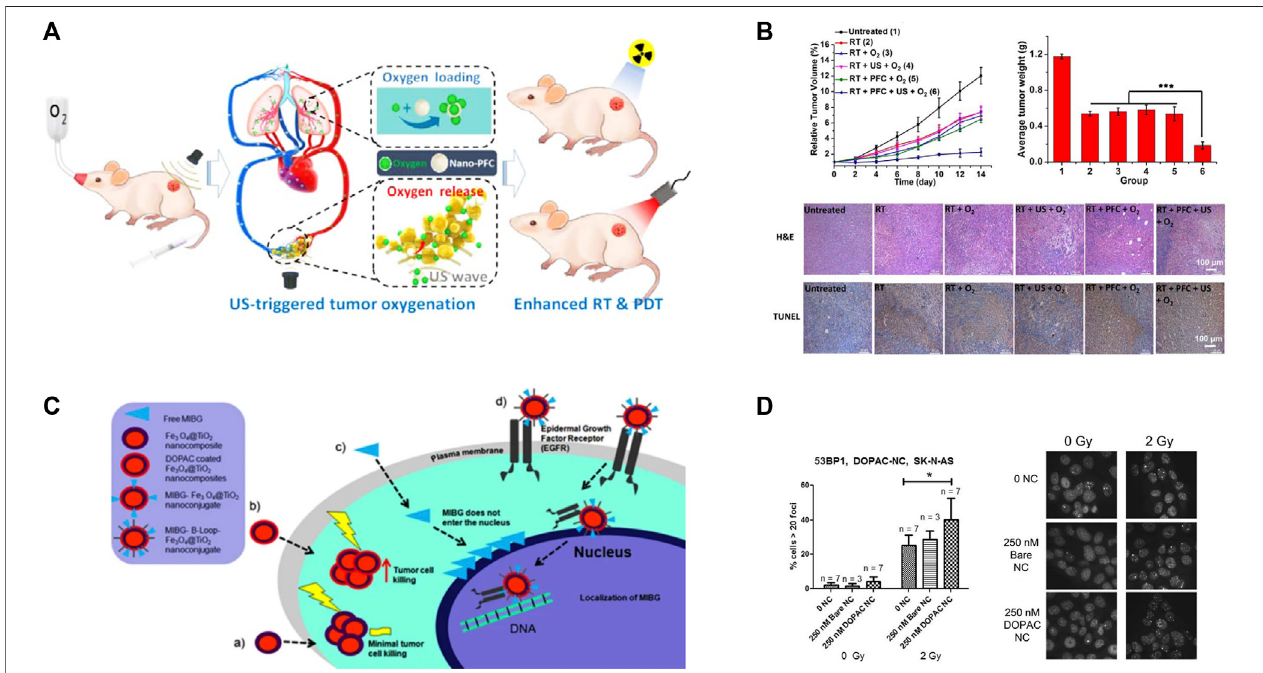
FIGURE4| NanotechnologyenhancesradiotherapyinNB. (A – B) Thetumorhypoxicmicroenvironmentwasmodulatedusingper fl uorocarbonnanoparticlesasan oxygen shuttle, which signi fi cantly improved the therapeutic effect of PDT and RT on tumors. Reproduced with permission from: Xuejiao Song, Liangzhu Feng, Chao Liang, Kai Yang, and Zhuang Liu. Ultrasound triggered tumor oxygenation with oxygen-shuttle nanoper fl uorocarbon to overcome hypoxia-associated resistance in cancertherapies.Nanoletters,2016,16(10):6145 – 6153(Songetal.,2016).Copyright2016,AmericanChemicalSociety. (C – D) SchematicdiagramofMIBGand DOPAC-coated Fe3O4@TiO2 as potential radiosensitizers for NB. Reproduced with permission (Liu et al., 2021). Copyright 2021, Springer